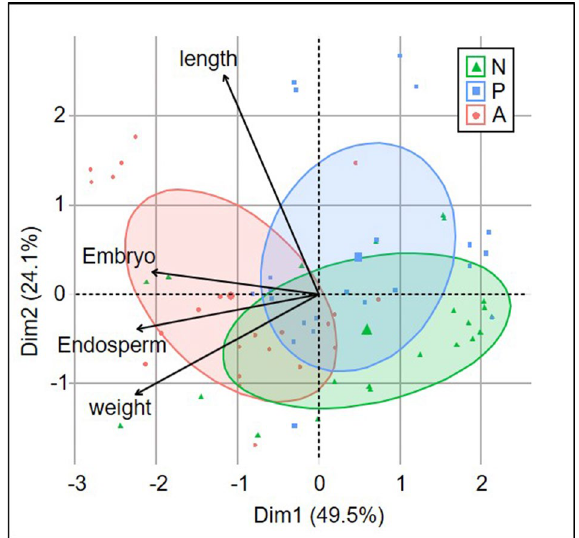
Figure 5. Principal component analysis (PCA) for the data concerning the share of alive cells in embryo and endosperm, and the biometric features of seeds, the three samples of 22 seeds collected from natural site (N), and from ex situ plantation of Polish (P) and Alpine (A) origin are